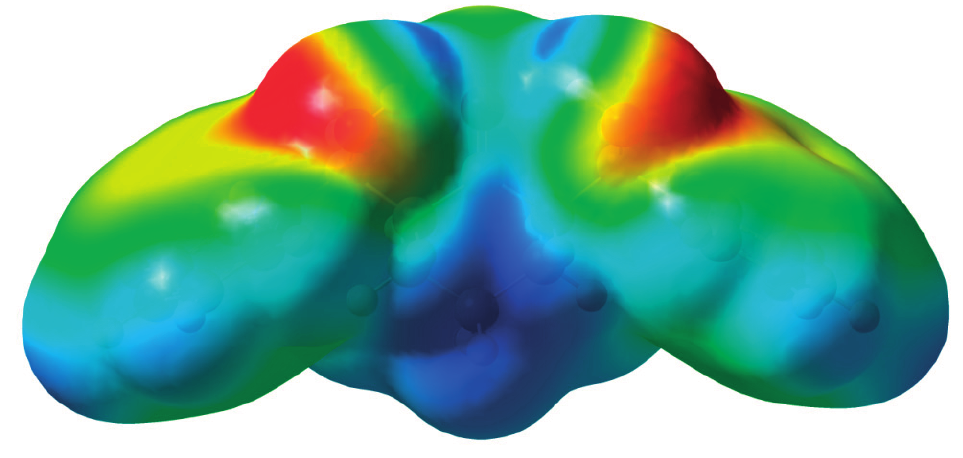
Figure 6. Molecular Electrostatic potentials (MEP) mapped on the electron density surface calculated by the DFT/B3LYP